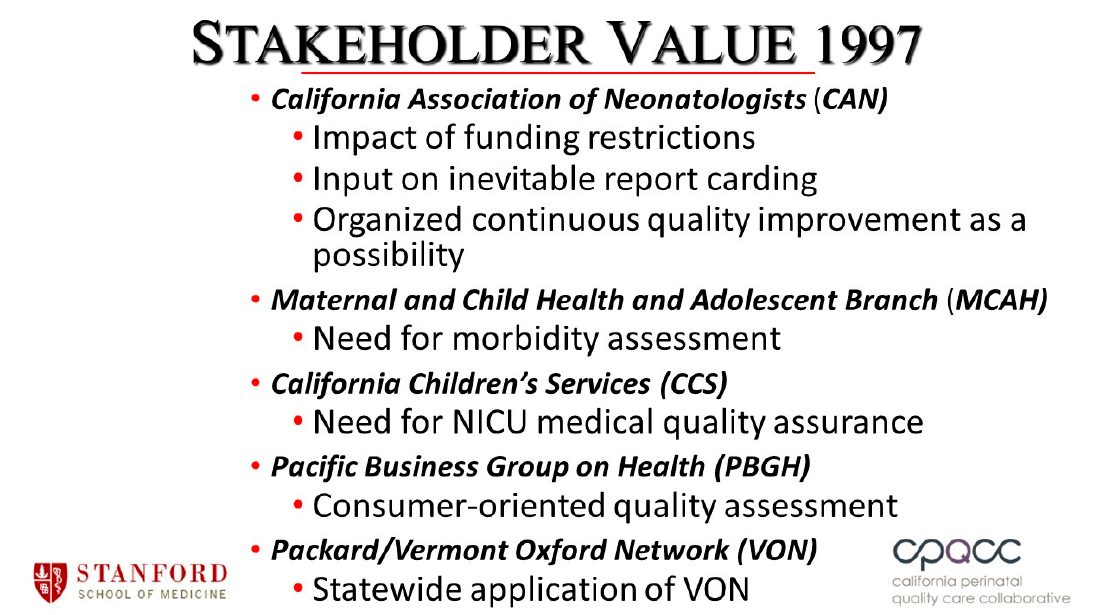
Figure 1. Founding partners and stakeholders involved in the launch of the California Perinatal Quality Improvement Collaborative (CPQCC).